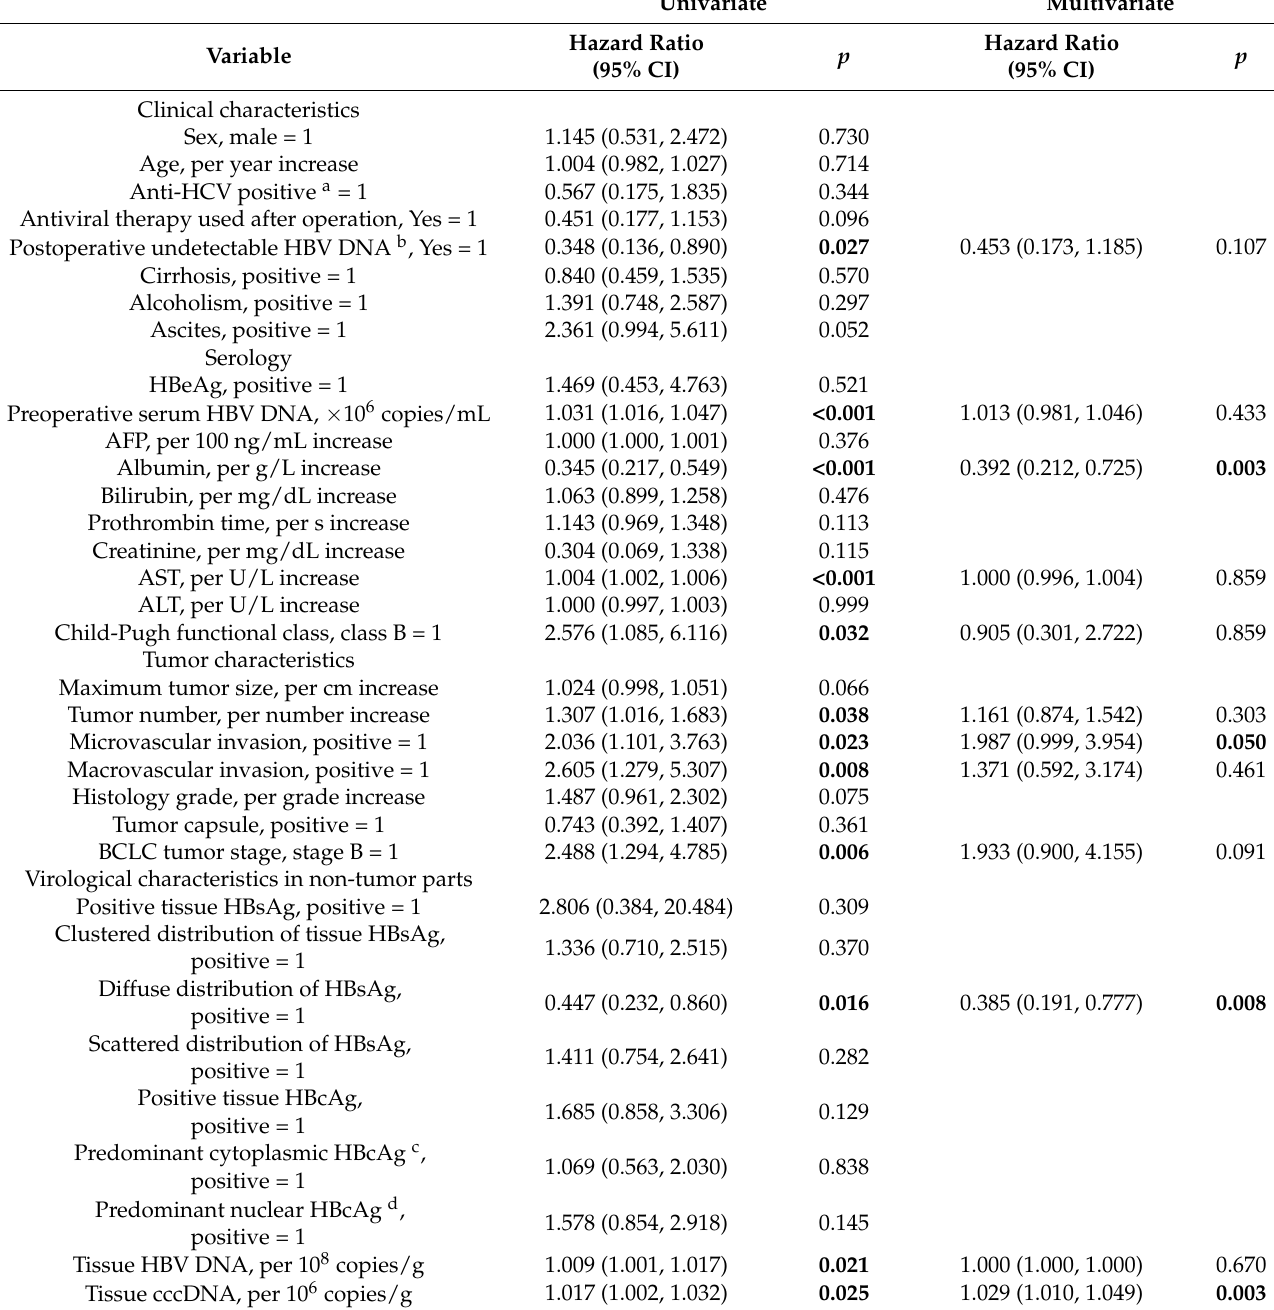
Table 3. Cox proportional hazard analysis for clinicopathological and virological parameters in relation to overall survival.